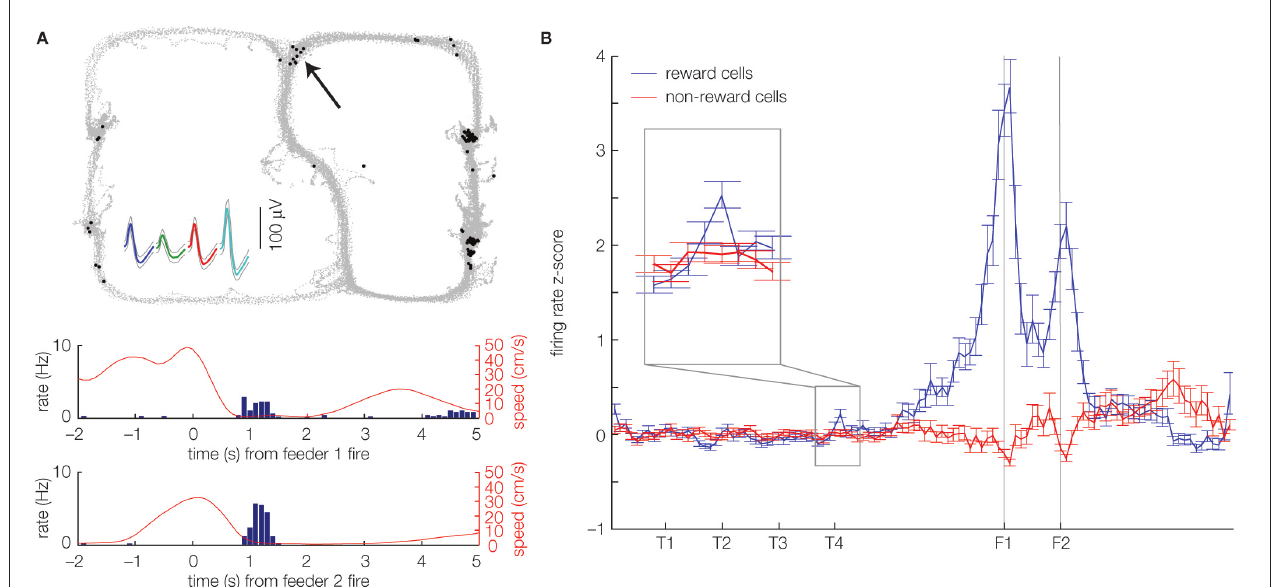
Figure 2 | Ventral striatal neurons show covert expectation of reward at a maze choice point. (A) Example of a reward-responsive neuron in ventral striatum that also fires spikes at other points on the maze, notably at the choice point (black arrow). The top panel shows the rat’s path on the track (gray dots), with the black dots indicating the location of the rat when a spike was fired. This neuron responded to reward delivery at the two feeder sites on the right side of the track, as indicated by the transient increase in firing rate at the time of reward delivery (peri-event time histograms, bottom panels). Data taken from a variation on the Multiple-T task published by van der Meer and Redish (2009a).